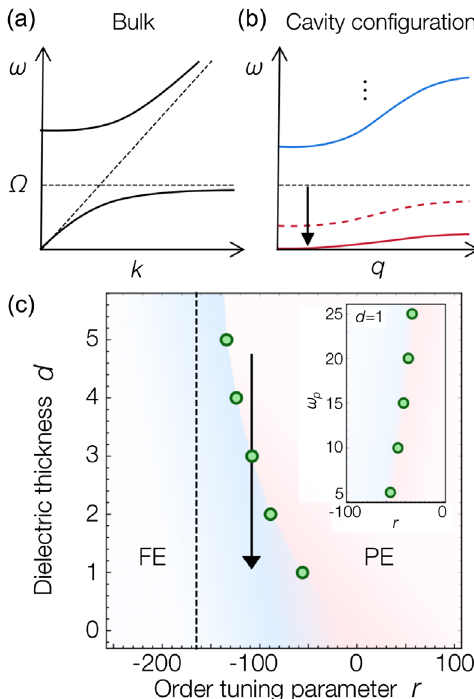
FIG. 3. Summary of the cavity-induced changes of the collec- tive excitations and the phase diagram. (a) Bulk band dispersions. The hybridization between a photon and an optical phonon at the frequency Ω (black dashed lines) leads to two gapped branches corresponding to the upper and lower transverse phonon polar- itons (black solid curves). (b) Collective excitations confined in the cavity as a function of the in-plane wave vector q . The hybridization leads to softening of the optical phonon modes (red curves and black solid arrow) and also supports the coupled surface modes (blue curve). (c) Phase diagram in the cavity geometry. As the tuning parameter r is decreased, the transition from the paraelectric phase (PE) to the ferroelectric phase (FE) occurs when the renormalized effective phonon frequency goes down to zero. The FE is enhanced in the cavity setting in comparison with the bulk geometry, for which the transition point is indicated by the black dashed line. The inset shows the dependence on the plasma frequency ω at the insulator thickness p 5 , U ¼ 1 , and d ¼ 1 . The parameters are c ¼ ℏ ¼ β ¼ 1 , ω p ¼ 10 2 g ¼ 3 . 5 , and the UV momentum cutoff is Λ c ¼